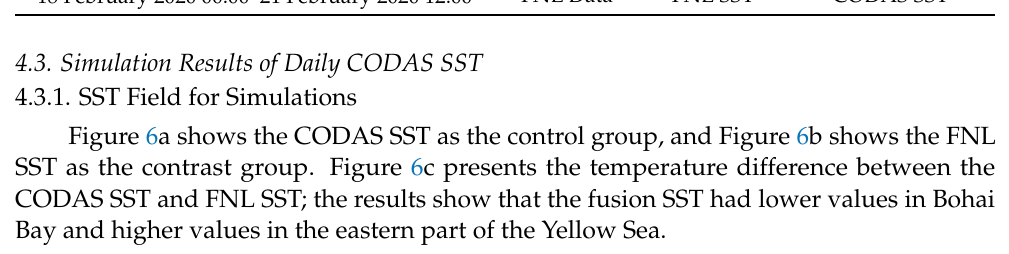
Table 1. The start time of simulation is at 00:00 UTC on February 18, 2020, the end time is at 12:00 UTC on February 21, 2020, the forecast horizon is 84h. Table 1. Scheme for numerical simulations.